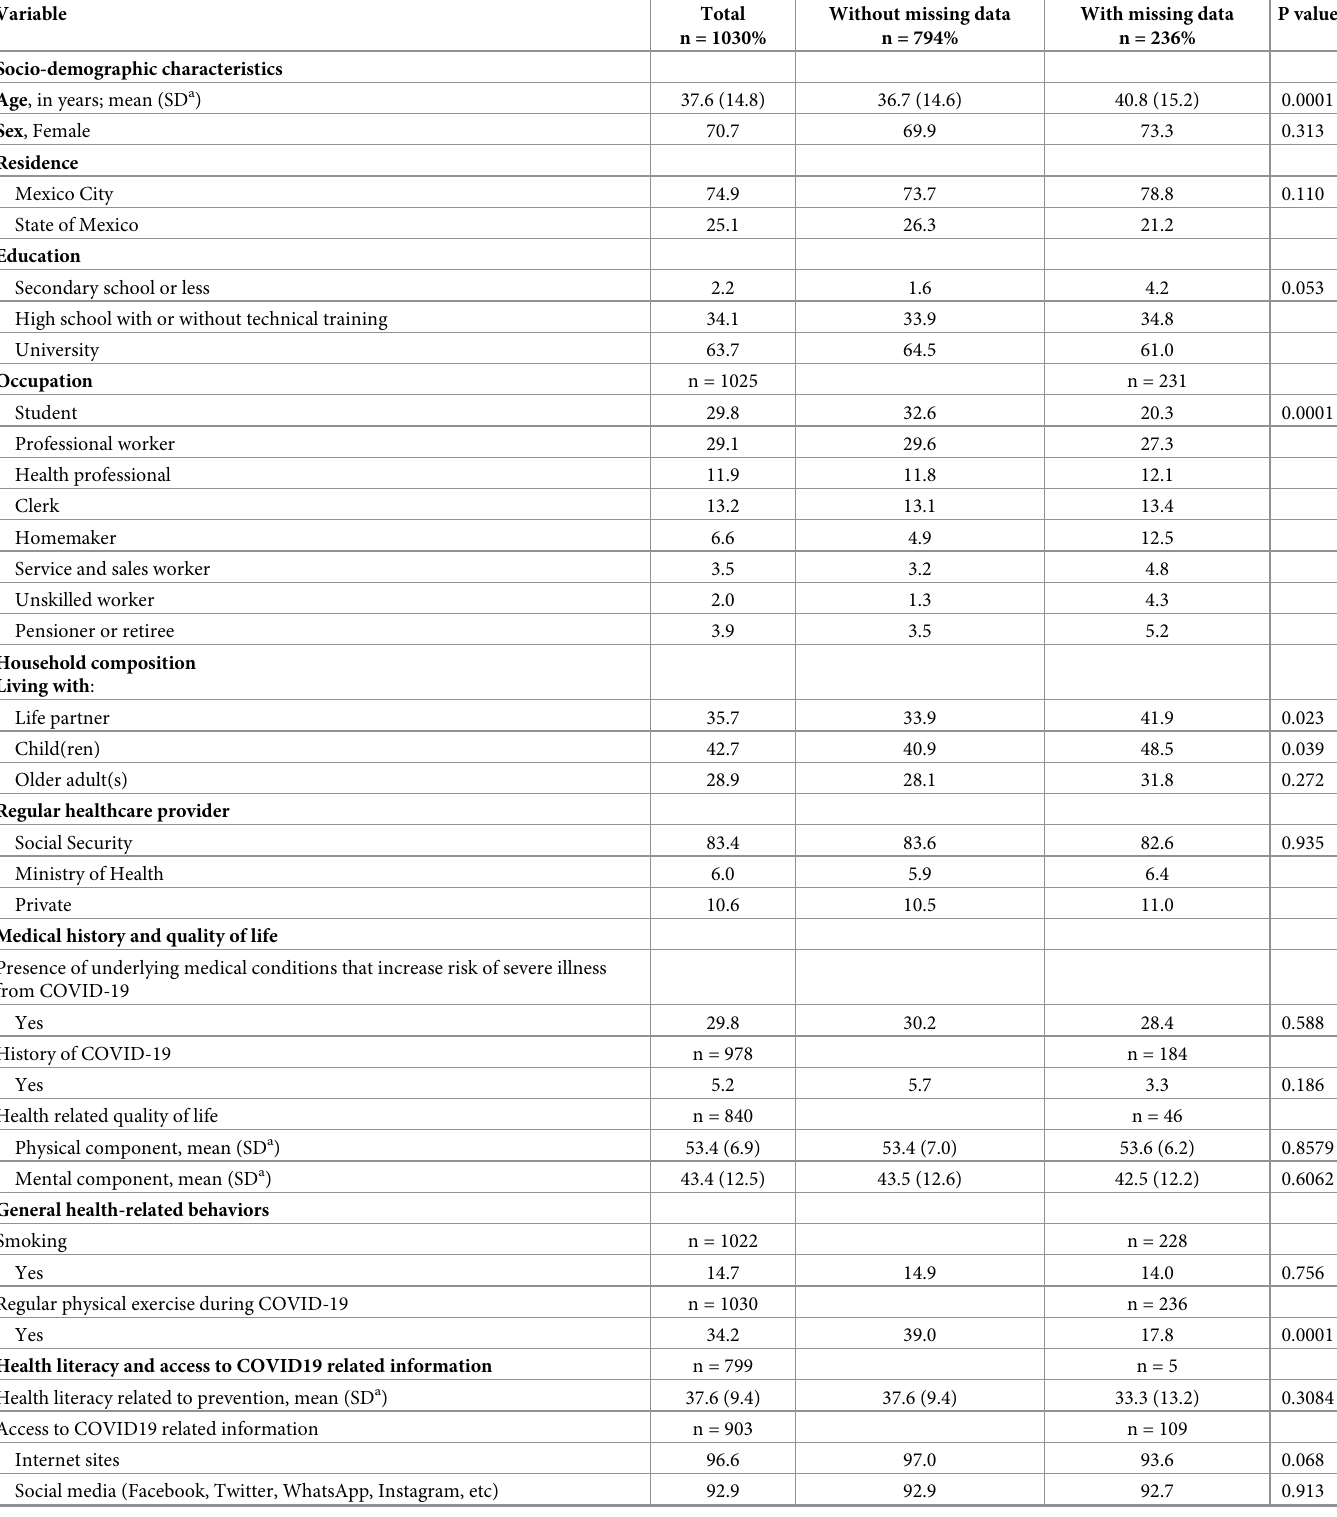
Table 1. Characteristics of participants with and without missing